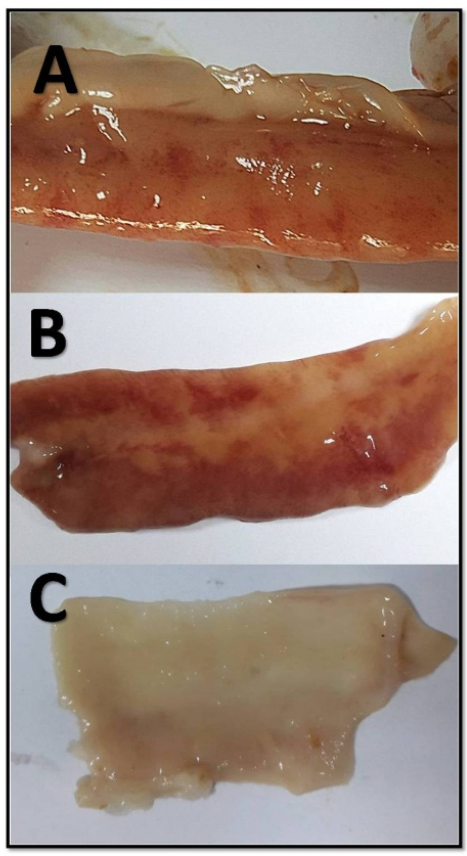
Figure 4. Different lesions of NE in the small intestine. ( A ) Thickened mucus, variable degrees of serosal blood vessel congestion. ( B ) Hemorrhage of the intestinal wall, fibrin deposition, and necrotic debris of the mucus membrane. ( C ) No gross lesions are present.